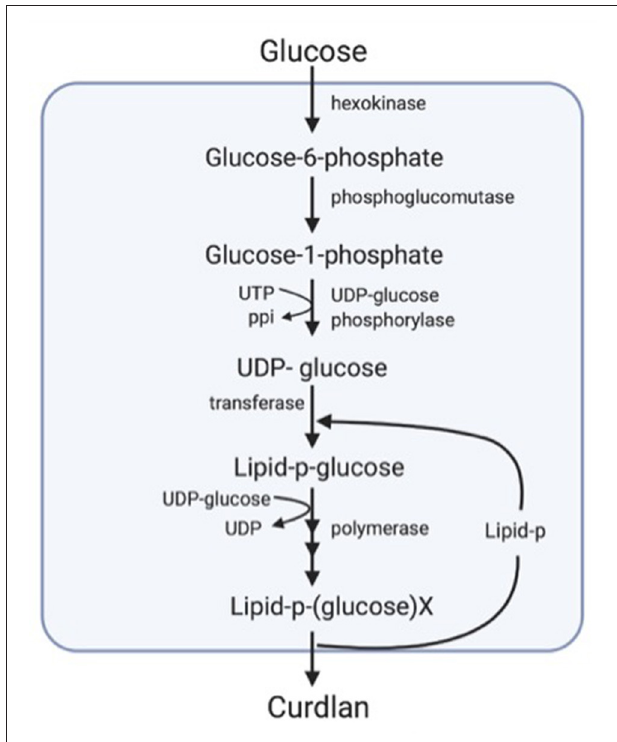
FIGURE 1 | Diagrammatic representation of the biosynthesis of curdlan (33).